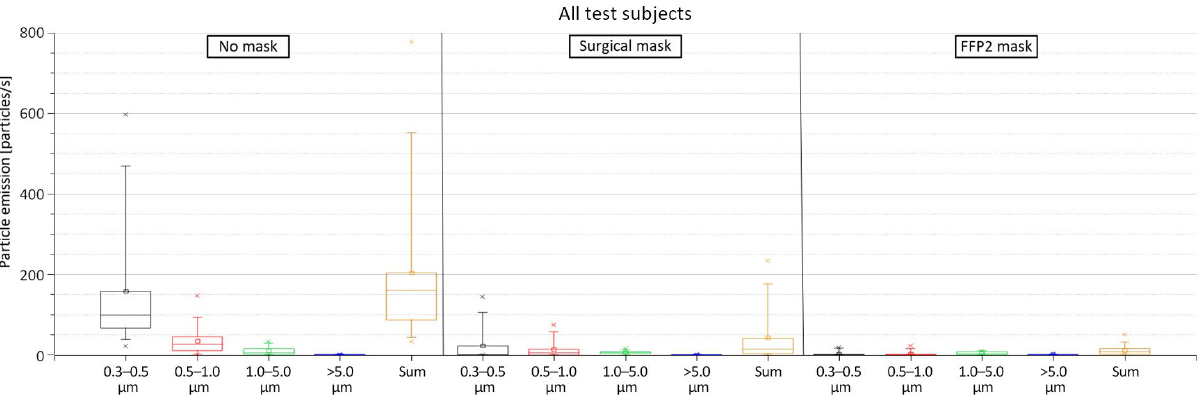
Figure 5. Particle emissions from all test subjects when wearing no mask, surgical mask, and FFP2 mask.